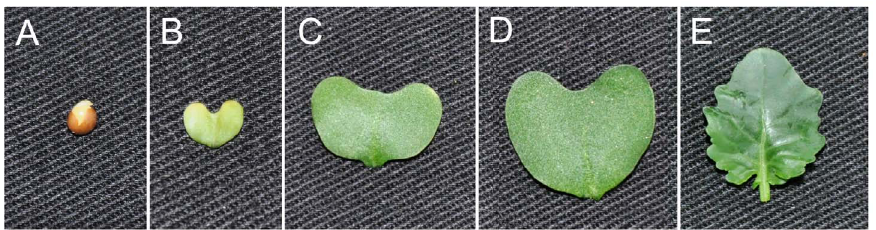
Figure 6. Images of the sampled tissues. A. seed; B. 3 day cotyledon; C. 7 day cotyledon; D. 11 day cotyledon; E. 11 day euphylla.